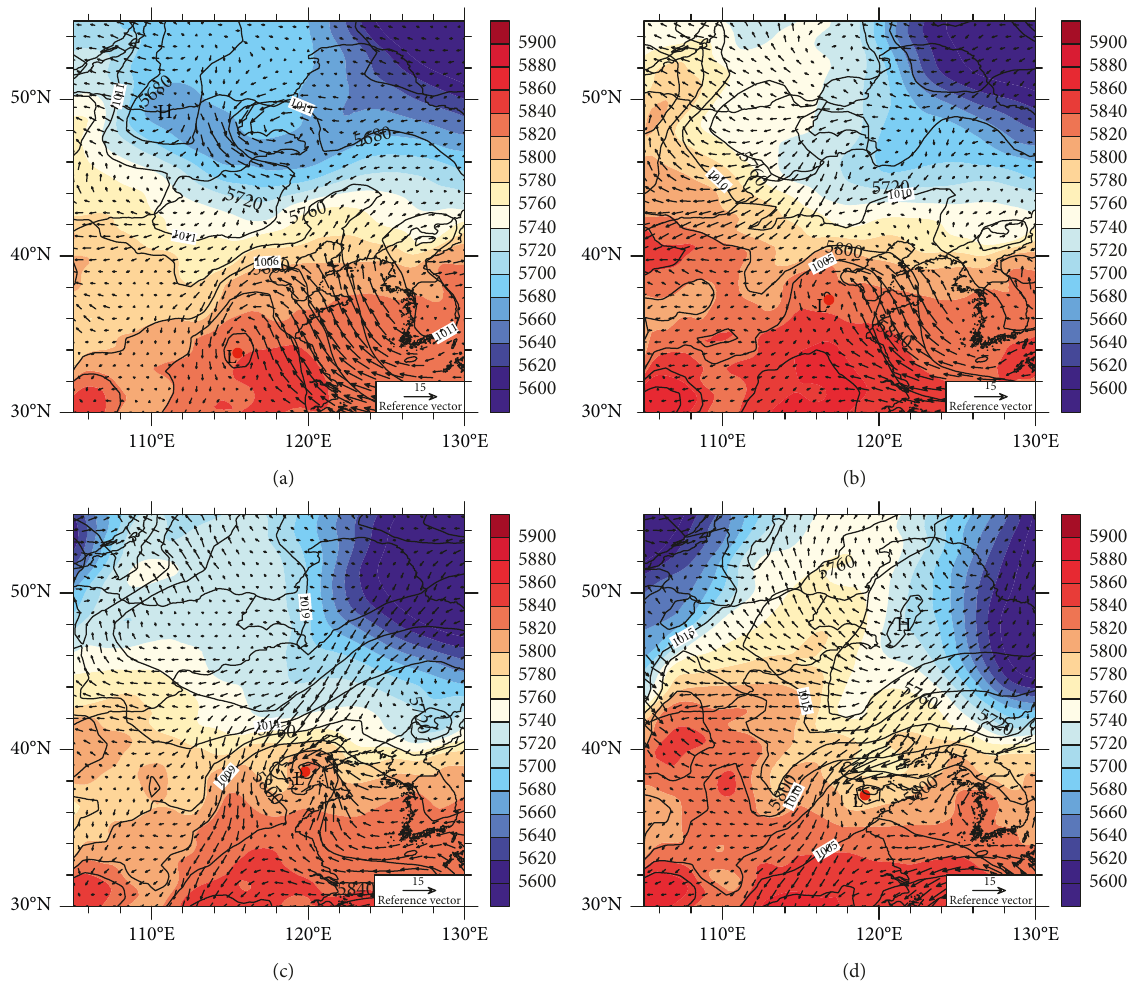
Figure 4: Surface circulation patterns: (a) 0000 UTC 14 August; (b) 1200 UTC 14 August; (c) 0000 UTC 15 August; (d) 1200 UTC 15 August. The contours represent the mean sea level pressure (hPa), the vectors represent the 10m wind speed (m/s), the shading represents the 1000–500hPa thickness (m), and the red dots represent the location of